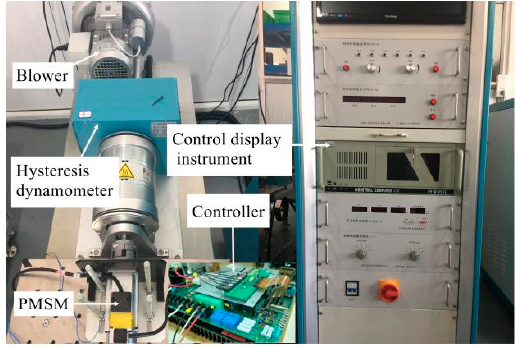
Figure 7. The testbench for PMSM drive system.